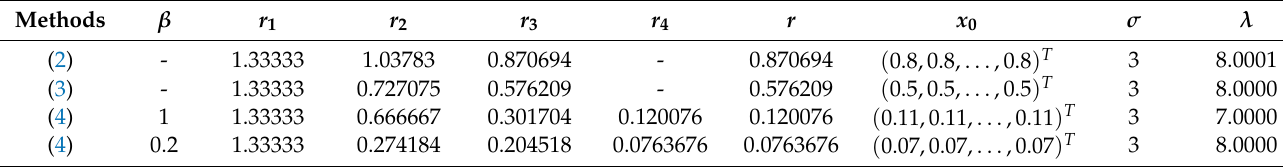
Table 4. Radii of convergence for Example